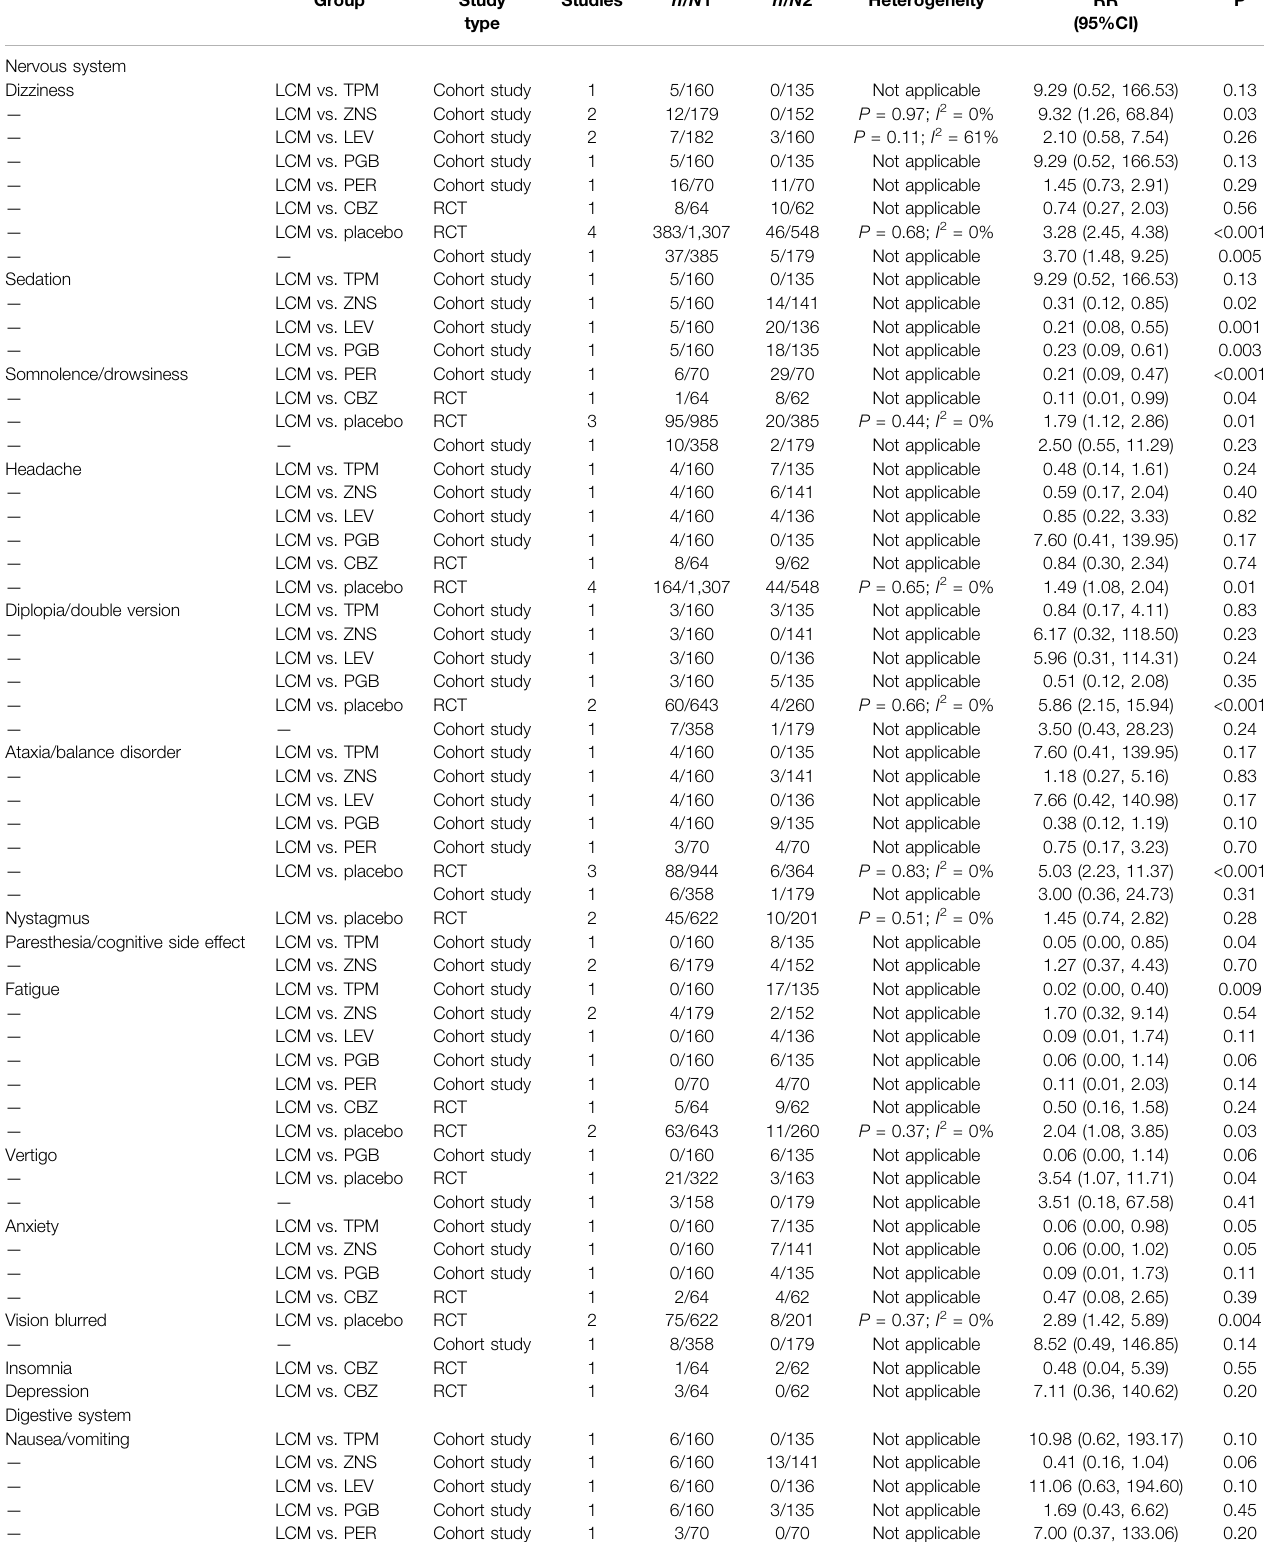
TABLE 2 | Meta-analysis of safety outcomes of lacosamide vs. placebo or other